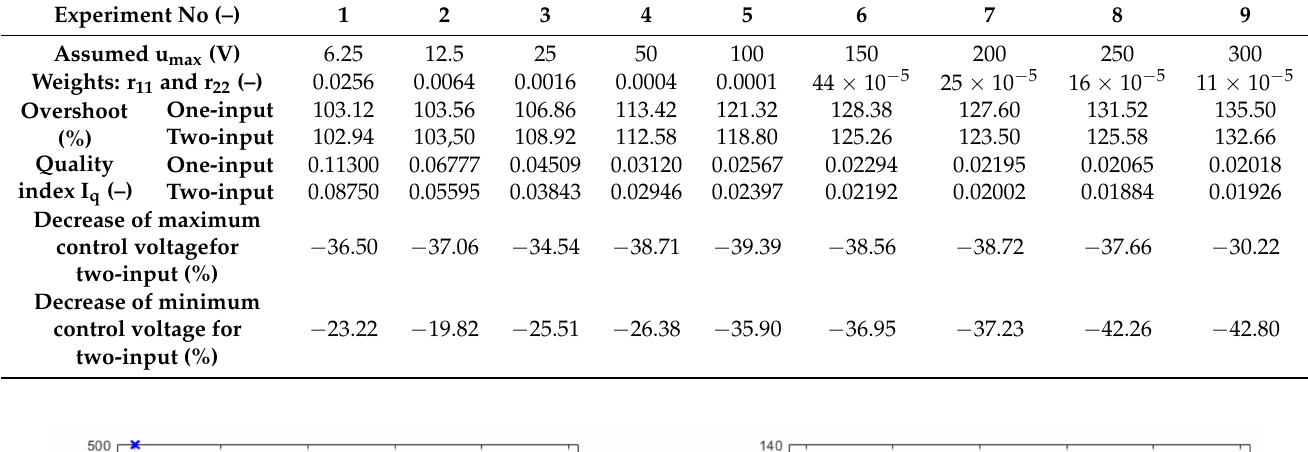
Table 6. Values of parameters in a comparison analysis.